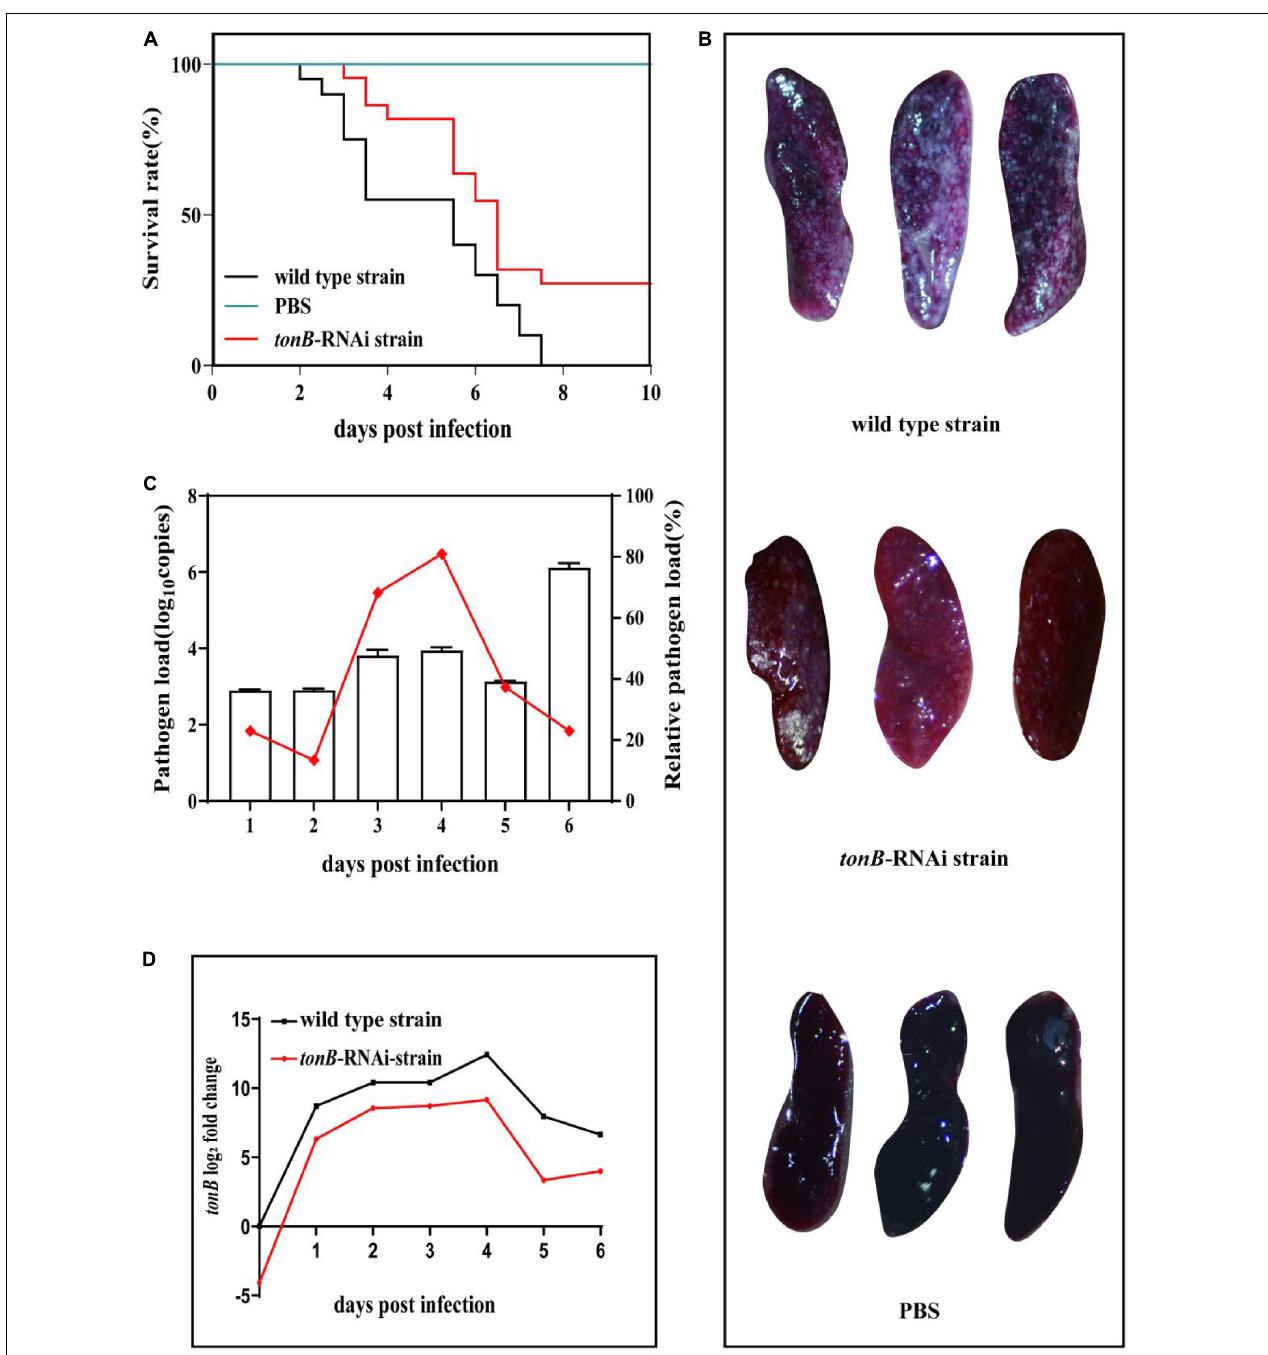
FIGURE 3 | Pathogenicity of two strains of Pseudomonas plecoglossicida to Epinephelus coioides . (A) Survival rate of E. coioides infected with wild-type strain or tonB -RNAi strain. (B) Symptoms of E. coioides spleen after infection of wild-type strain or tonB -RNAi strain. (C) Pathogen load of tonB -RNAi strain of P. plecoglossicida in the spleens of E. coioides during infection. The bar graph represents the pathogen load and is represented by the copy number of gyrB gene; the line graph represents the relative pathogen load, which is represented by (copy number of gyrB gene of tonB -RNAi strain/copy number of gyrB gene of wild-type strain). (D) mRNA level of tonB gene of P. plecoglossicida in E. coioides spleen during infection.